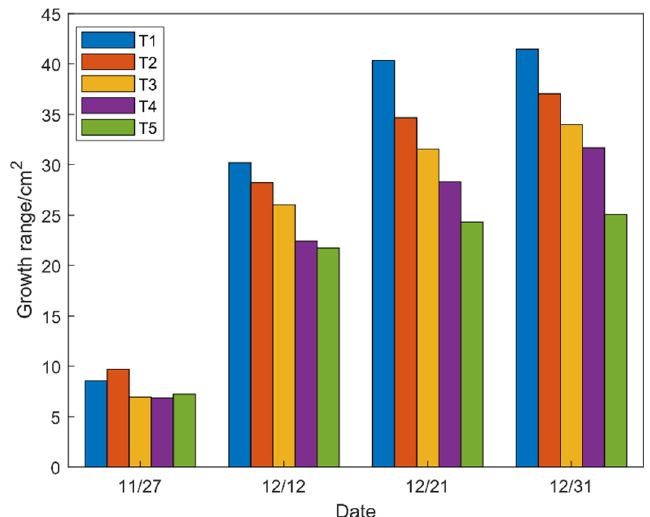
Figure 12. GR results of T1–T5 water treatments in the experiment.